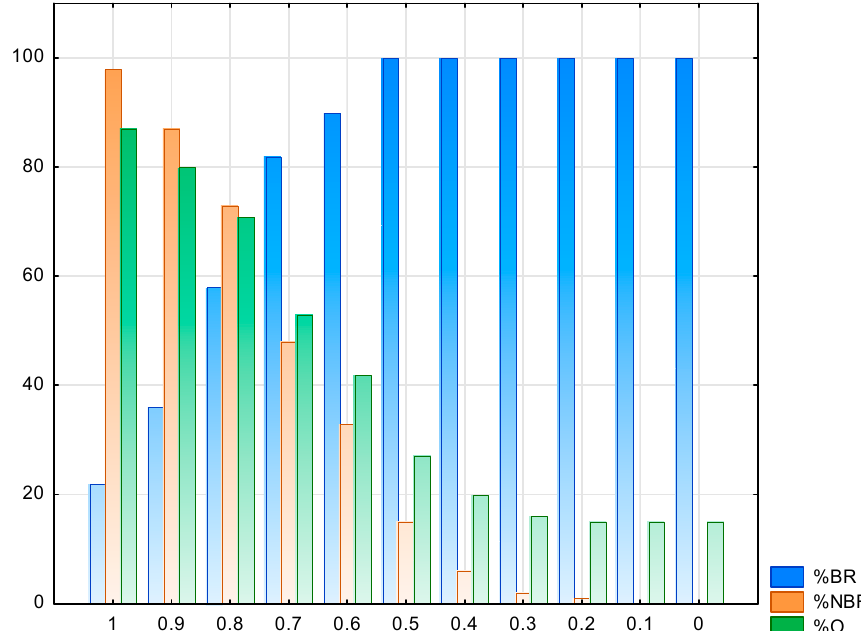
Figure 3. Percentage of correct predictions using the DEA model. Legend: BR—Estimation Accuracy for Bankrupt Businesses. NBR—Estimation Accuracy for Non-Bankrupt Businesses, O—Overall Estimation Accuracy.